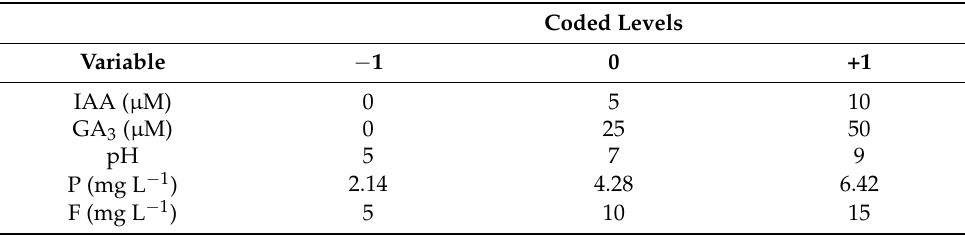
Table 1. Values of auxin (IAA), gibberellin (GA 3 ), pH, phosphorus, and fluoride initial concentration for the definitive screening design experiment.